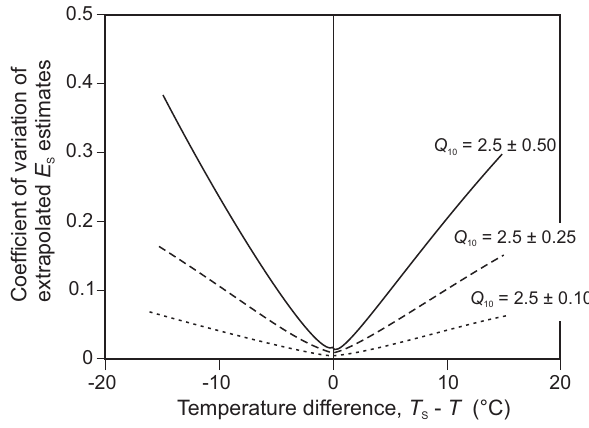
Fig. 8. Analysis of the errors in estimates of the BVOC emission factors, E S , due to extrapolations beyond the measurements, i.e. the coefficient of variation (standard deviation per sample mean) of E S estimates extrapolated to given temperature using uncertain temper- ature scaling functions. Often, especially in the field, the measure- ments are conducted at a temperature, T , different from the stan- dardized temperature, T S (that is typically taken as 30 ◦ C), and these values are then extrapolated to T S . When there is no information about the shape of the isoprenoid emission vs. temperature response curve, the original parameterization for the temperature functions of Guenther et al. (1991, 1993) is used as default. In this analysis, we characterize the shape of the temperature response curve by Q 10 value, i.e. the process rate at a temperature T + 10 ◦ C relative to the rate at the temperature T (Eq. 20). This analysis demonstrates that even minor changes in the shape of the temperature response of the emissions result in large errors in E S , especially if the data are extrapolated over a large temperature range ( T S − T ) . The sim- ulation analysis is based on stochastic perturbations in Q 10 using Monte Carlo method. For each simulation, 1000 different estimates of Q 10 and E S were